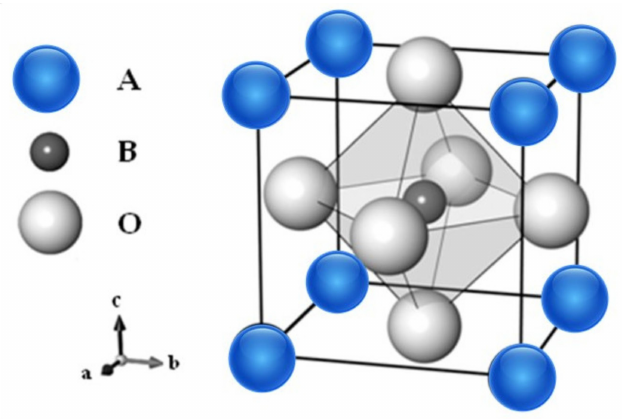
Figure 2. Crystal structure of perovskite oxide with ABO 3 composition. (Concept adopted with permission from [43]. Copyright 2020, MDPI, Open